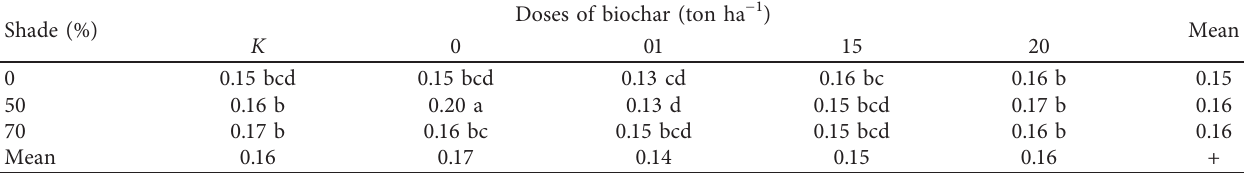
Table 8: Effects of biochar and shade application on the available magnesium cmol (+).kg − 1 .